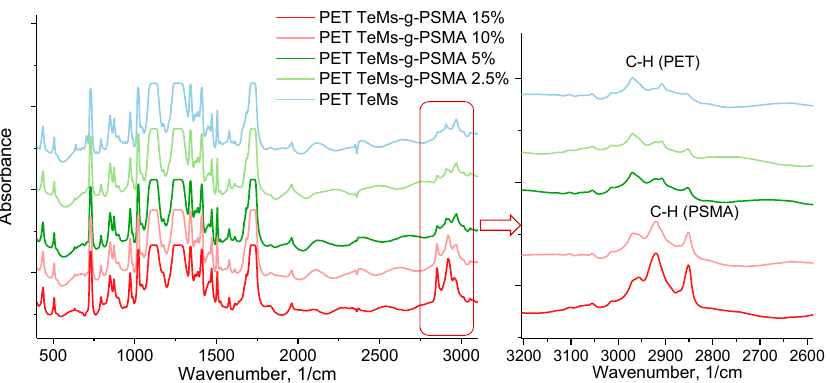
Figure 3. FTIR spectra of original PET TeMs in comparison with SM grafted PET TeMs at different concentrations of monomer.